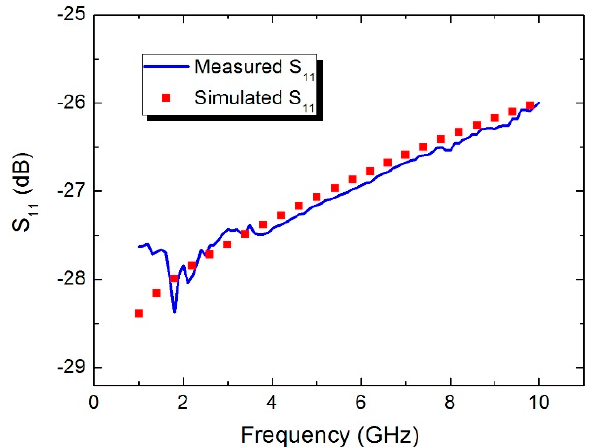
Figure 10. Measured S 11 of the power sensor over the frequency band of 1–10 GHz.